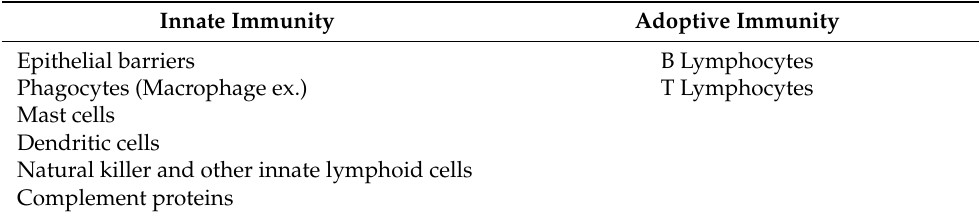
Table 1. Immune system types and constituents. Innate Immunity Adoptive Immunity Epithelial